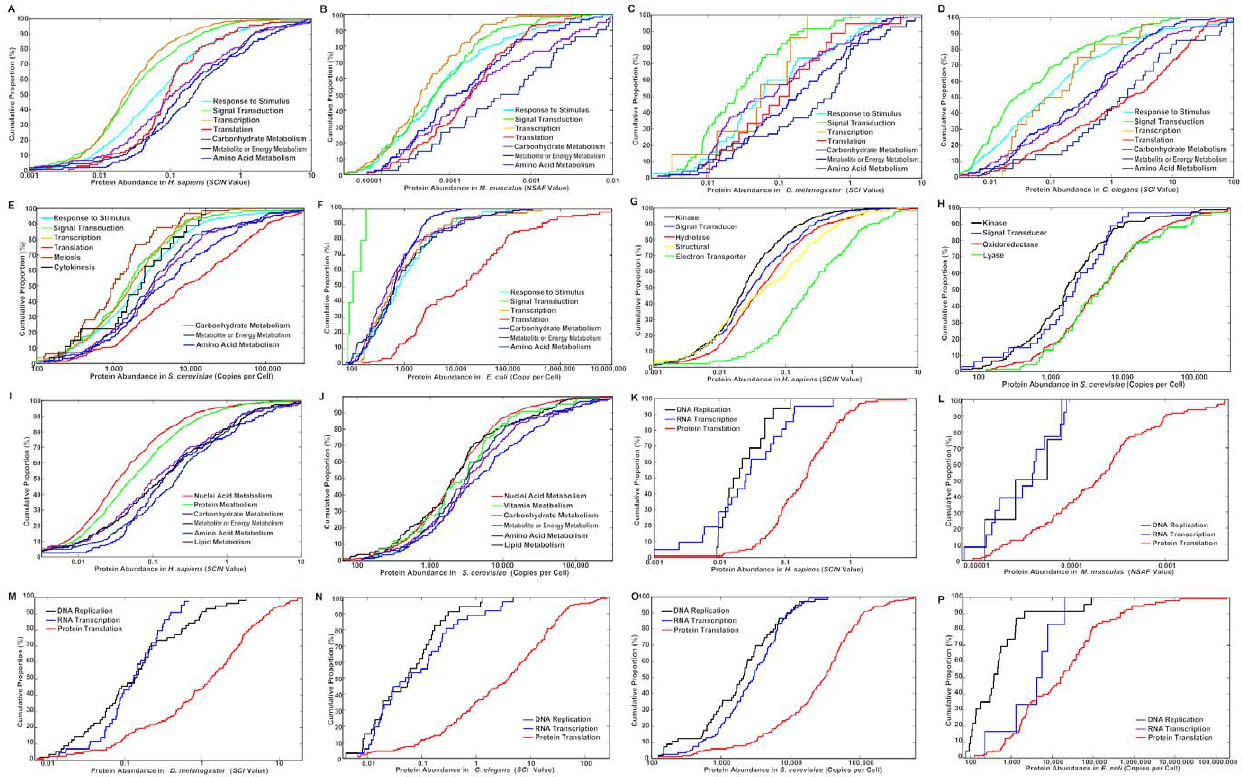
Figure 4. Proteome-wide correlation of proteins’ abundance with their functional categorization across six species. Abundance distribution of proteins in the mass and the information categories was compared by cumulative curves in H. sapiens ( A ), M. musculus ( B ), D. melanogaster ( C ), C. elegans ( D ), S. cerevisiae ( E ), and E. coli ( F ). Stratified comparison: mass vs. information processing activities in H. sapiens ( G ) and S. cerevisiae ( H ); metabolism subclasses in H. sapiens ( I ) and S. cerevisiae ( J ). Comparison among biogenesis machines of three bio-molecules in H. sapiens ( K ), M. musculus ( L ), D. melanogaster (M), C. elegans ( N ), S. cerevisiae ( O ), and E. coli ( P ).